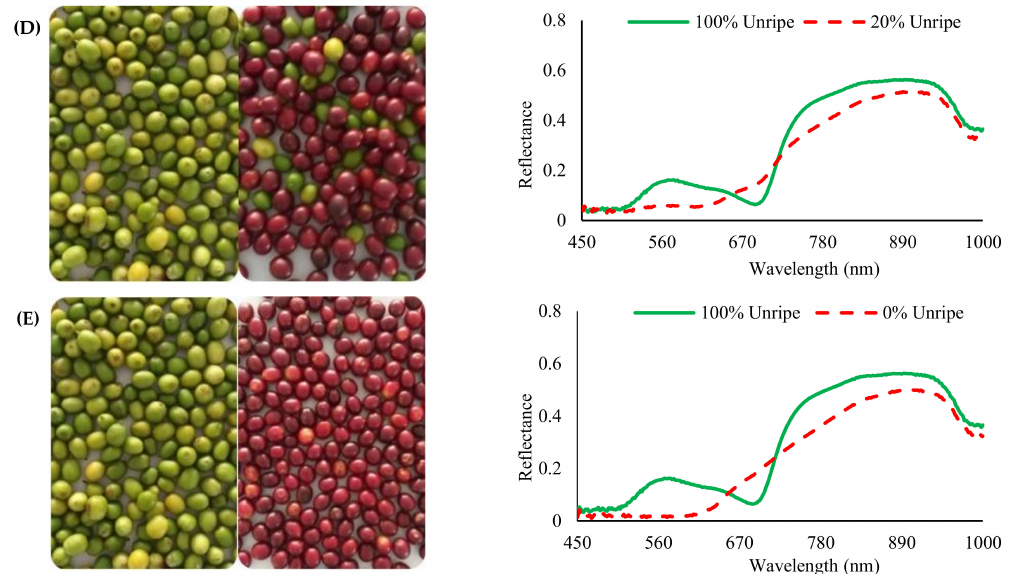
Figure 5. Spectral reflectance patterns for different ripeness percentages of coffee fruits ( A ) 100% and 80% of unripe; ( B ) 100% and 60% of unripe; ( C ) 100% and 40% of unripe; ( D ) 100% and 20% of unripe; and ( E ) 100% of unripe and 100% of ripe fruits.